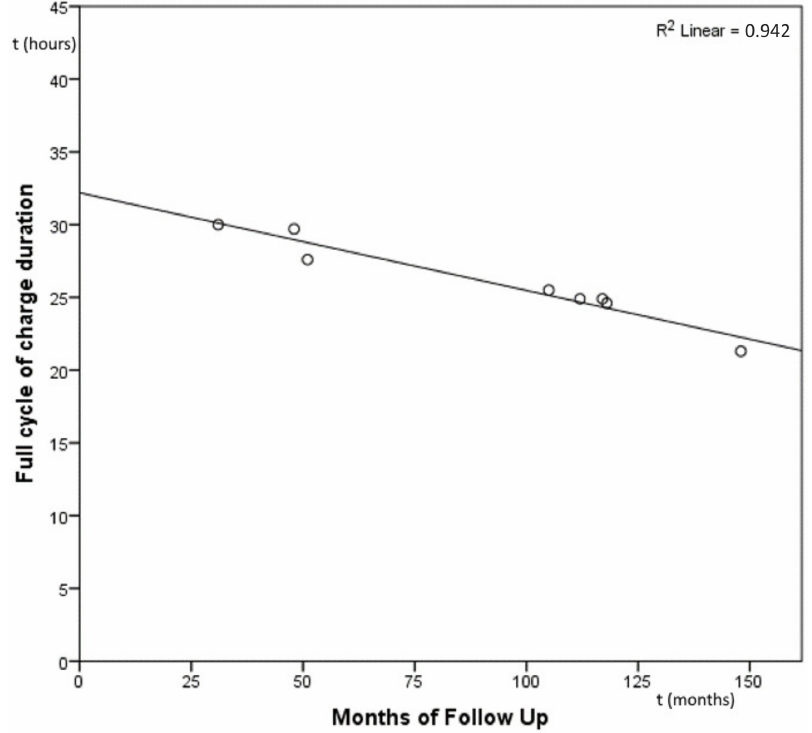
Figure 2. Scatterplot plotting showing a a strong negative significant correlation between the follow- up period and the percentage of residual battery lifespan (Pearson Coefficient = − 0.970, p <